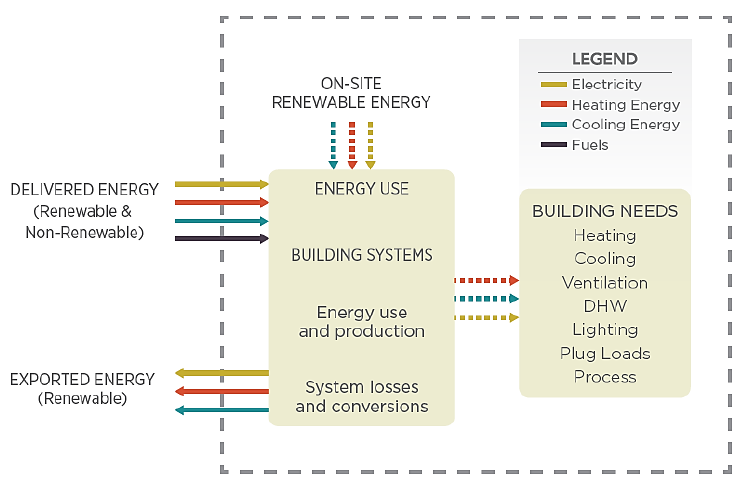
Figure 8. On-site energy transfer limit for zero energy balance [40]. Note: “The dashed lines represent energy transfer within the boundary, and the solid lines represent energy transfer entering/leaving the boundary used for zero energy accounting.”